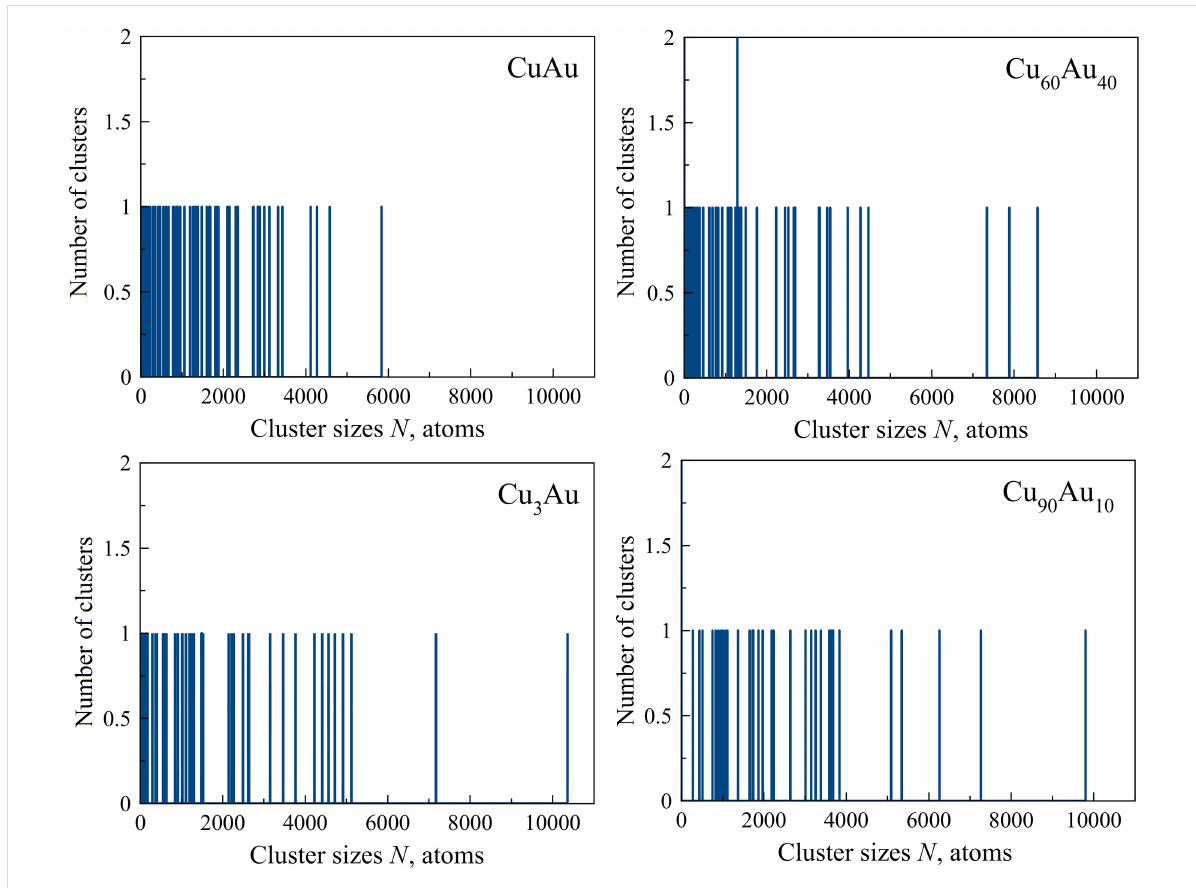
Figure 2: Size distribution of binary Cu–Au nanoparticles with different chemical compositions at T = 77